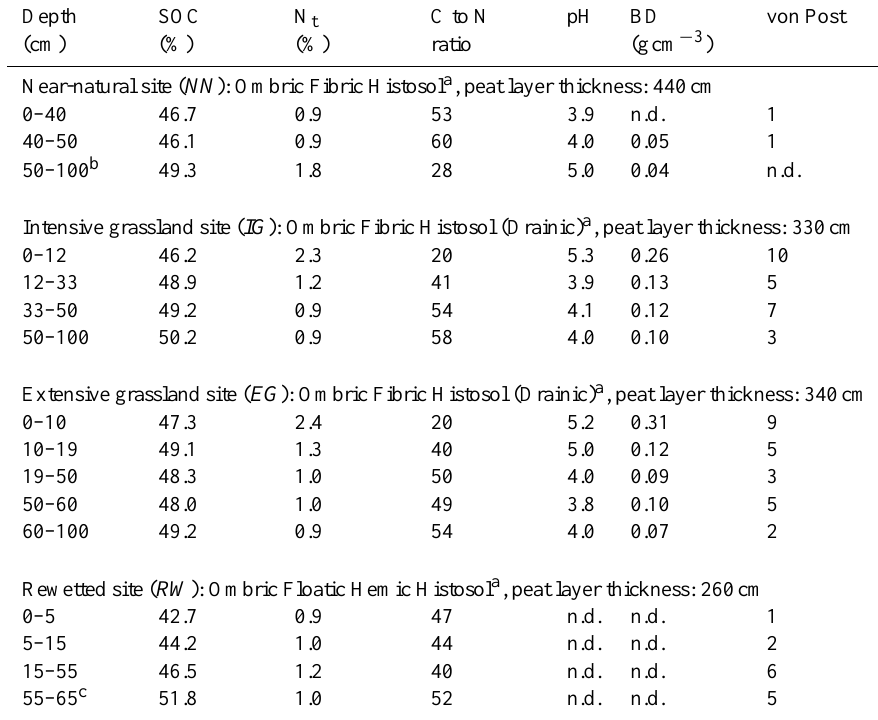
Table 2. Soil properties (0–100cm) of the study sites in the “Ahlen-Falkenberger Moor” peat bog. Depth